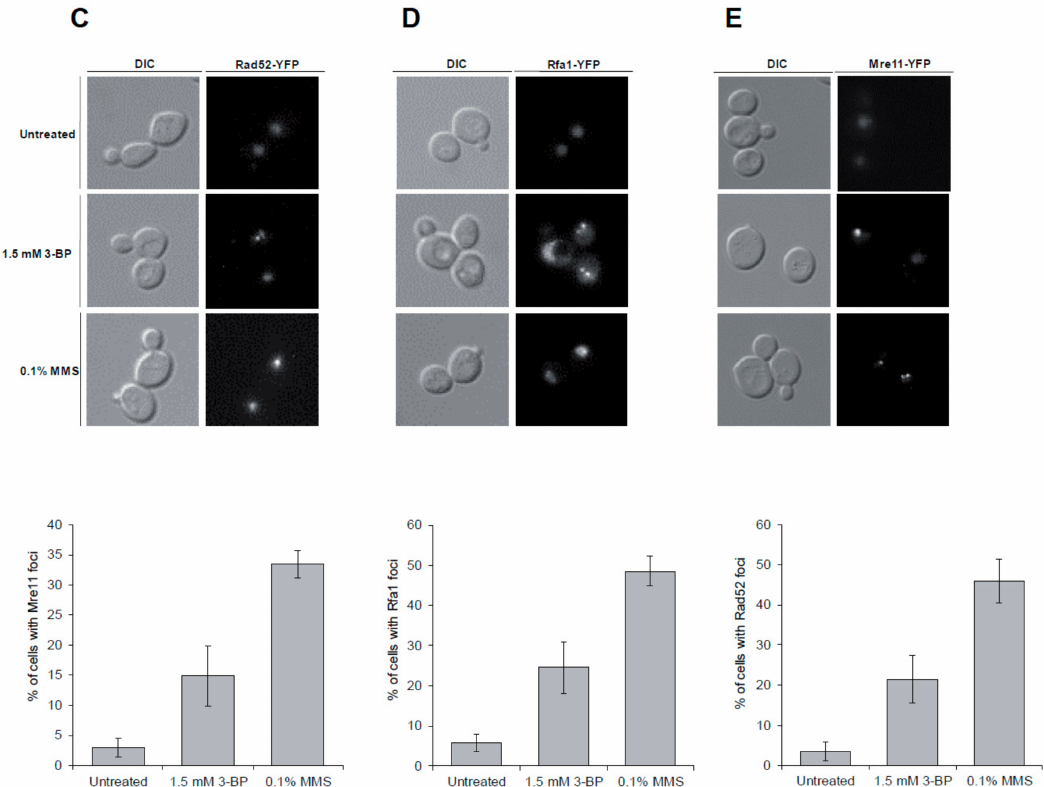
Figure 5. Homologous recombination is crucial for tolerance to 3-BP: ( A,B ) Homologous recombination, nonhomologous end-joining and base excision repair pathways are required for maintaining viability of yeast cells in the presence of 3-BP. Serial dilutions of indicated strains were plated on solid media in the presence or absence of 3-BP at 30 ◦ C and photographed after 3 days. ( C – E ) 3-BP treatment triggers formation of homologous recombination repair centers. Logarithmically growing cultures of cells bearing Mre11-YFP ( A ), Rfa1-YFP ( B ) and Rad52-YFP ( C ) were treated with 3-BP or MMS for 1.5 h. Next, cells were washed and processed for microscopic analysis. Error bars represent mean value ± standard deviations of mean ( n =